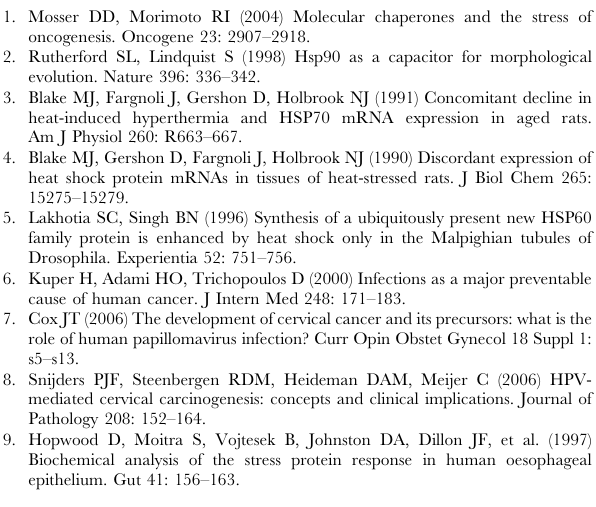
DOC) Figure S1 Predicted amino acid sequence and alignment of SEP53 proteins from 9 mammalian species. The highly conserved N-terminal Ca + binding domain spans amino acids 1 to 90. The diamond ( e ) designates the positions of the insertion sites of chimp, see figure 2. Porcine SEP53 also contain an insert in this region (Further details and functional analyses af porcine SEP53 are being presented